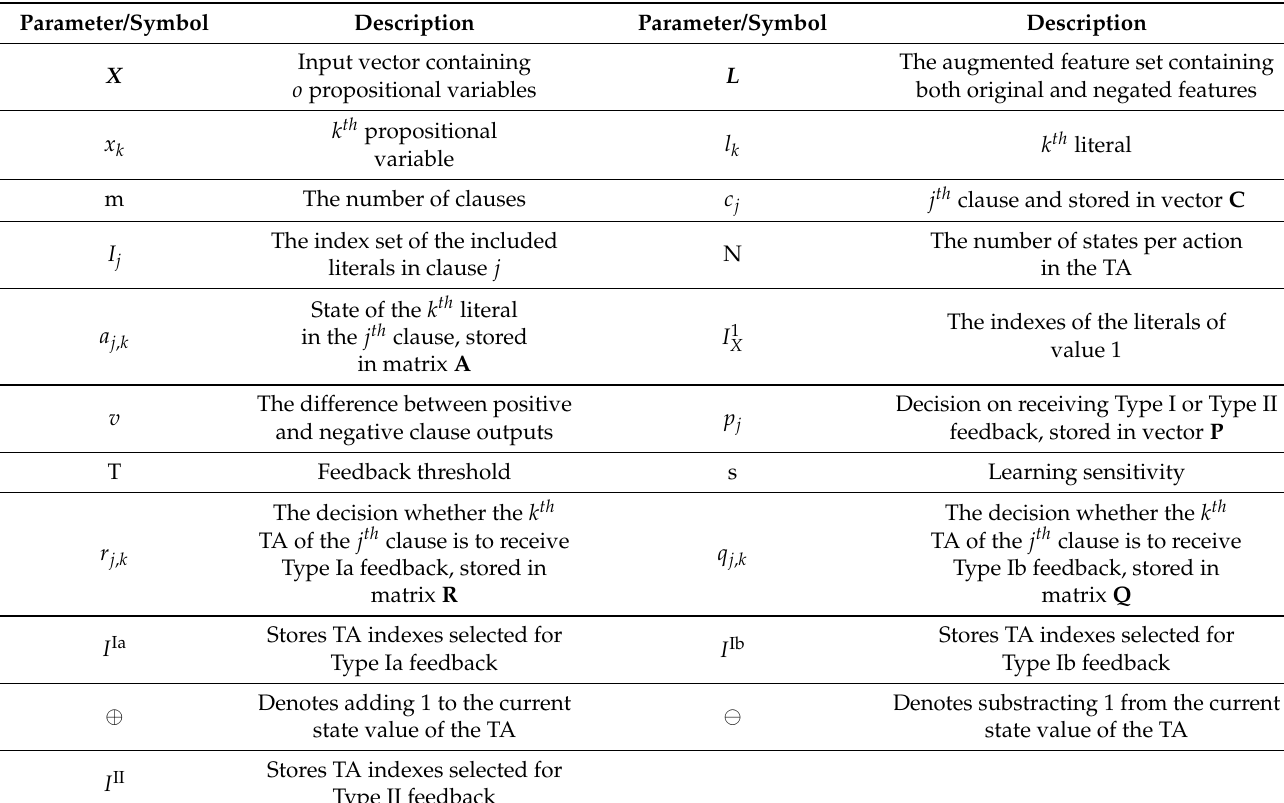
Figure 2. The TM structure. Table 1. Parameters and symbols used in Section